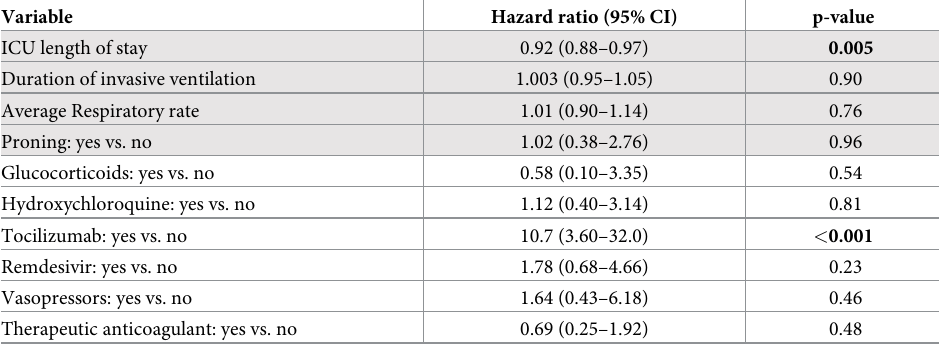
Table 3. Hazard risk of pneumothorax.